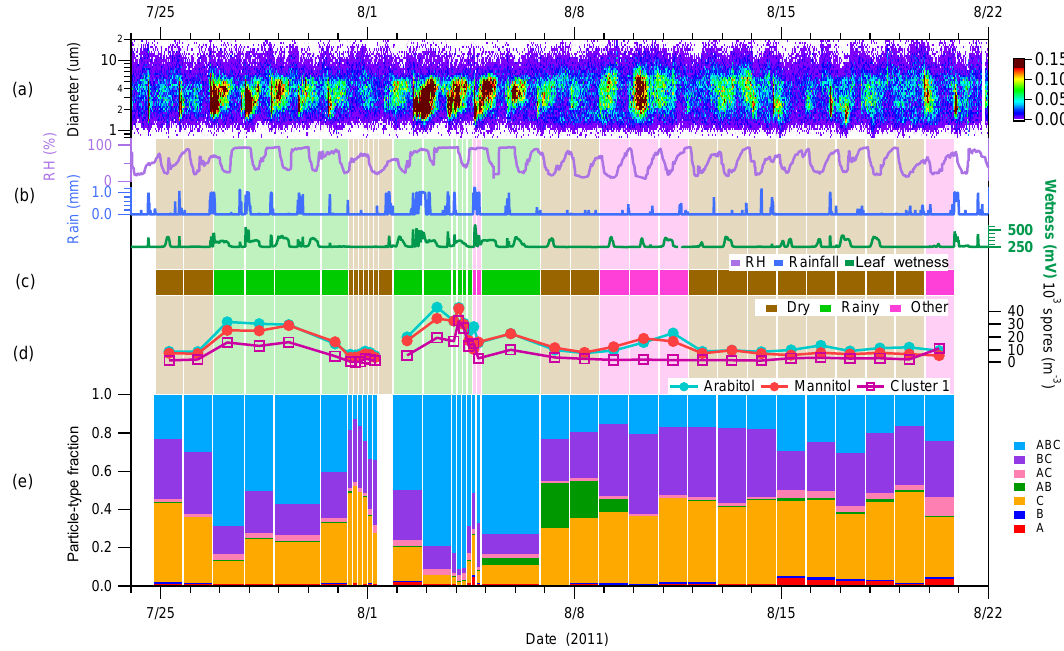
Figure 2. Time series of key species concentrations and meteorological data over entire campaign. (a) Fluorescent particle number size distribution measured with UV-APS instrument. Color scale indicates fluorescent particle number concentration (L − 1 ) . (b) Meteorological data: relative humidity (RH), disdrometer rainfall (millimeters per 15min), leaf wetness (mV). (c) Wetness category indicated as colored bars: green, Rainy; brown, Dry; pink, Other. Bar width corresponds to filter sampling periods. Lightened colored bars extend vertically to highlight categorization. (d) Colored traces show fungal spore concentrations estimated from molecular tracers (circles) and WIBS Cl1 data (squares). (e) Stacked bars show relative fraction of fluorescent particle type corresponding to each WIBS